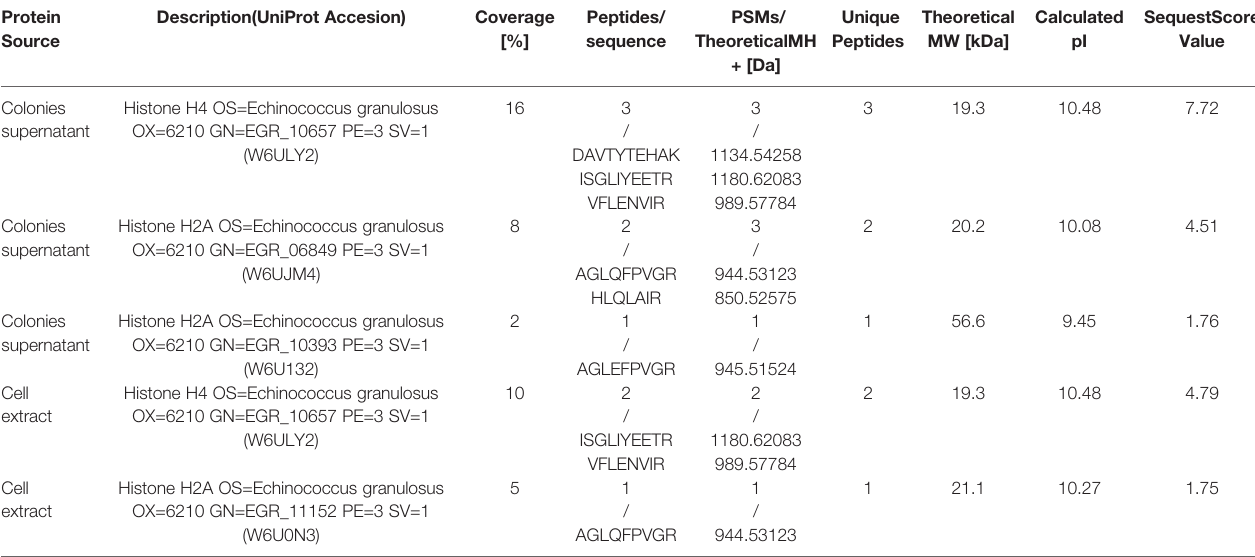
TABLE 2 | Histone identi fi ed by proteomic analysis: MS/MS-Data. Protein